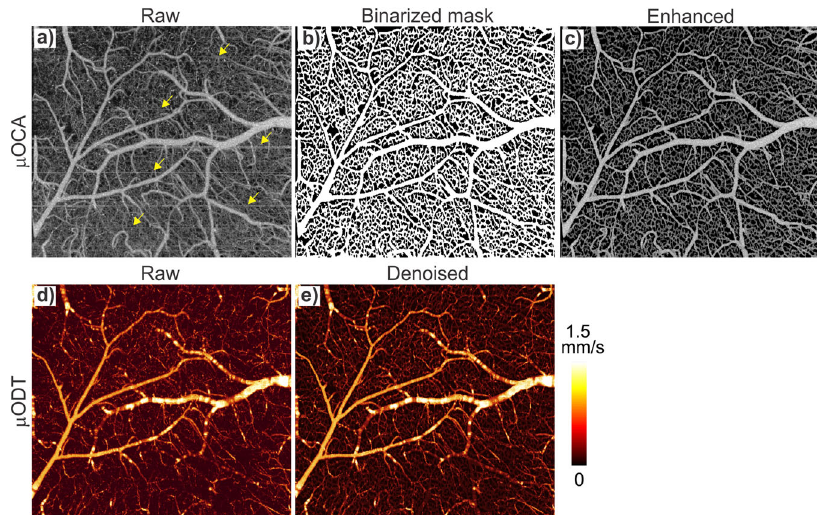
Fig. 2 Self-supervised learning to minimize motion artifacts and denoise in μ OCA (upper panel) and μ ODT (lower panel) images of awake mouse. Yellow arrows ( a ) point to motion artifacts in μ OCA that were removed by deep-learning-based image processing ( c ), where the vesselness mask ( b ) was derived from self-supervised learning for motion artifacts removal. Lower panels show the raw μ ODT image ( d ) was effectively denoised ( e ) by self- supervised learning. Image size 2.3 × 1.2 × 2 mm 3